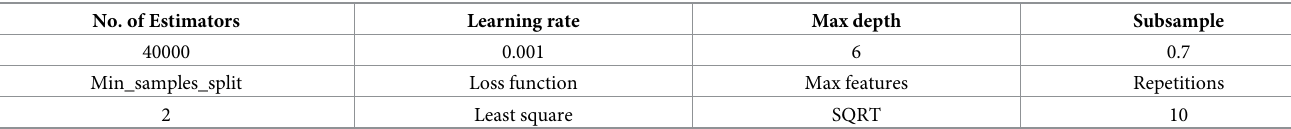
Table 2. The parameters for our DC-based gradient boosting tree (GBT) models.